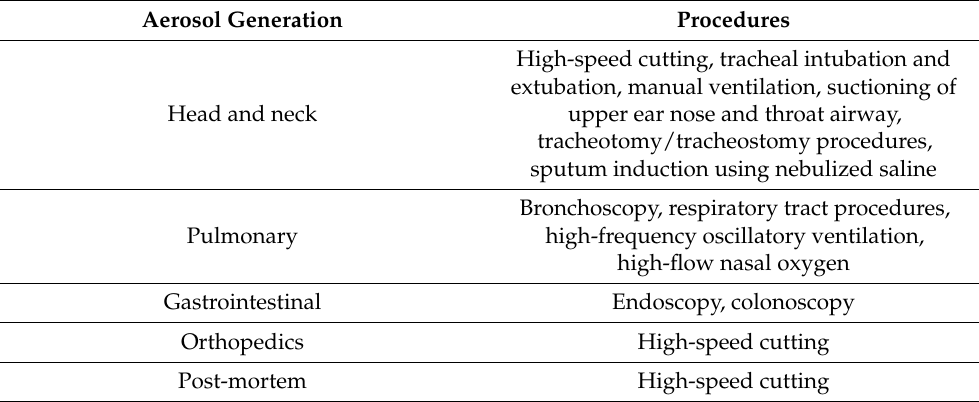
Table 1. Medical procedures generating